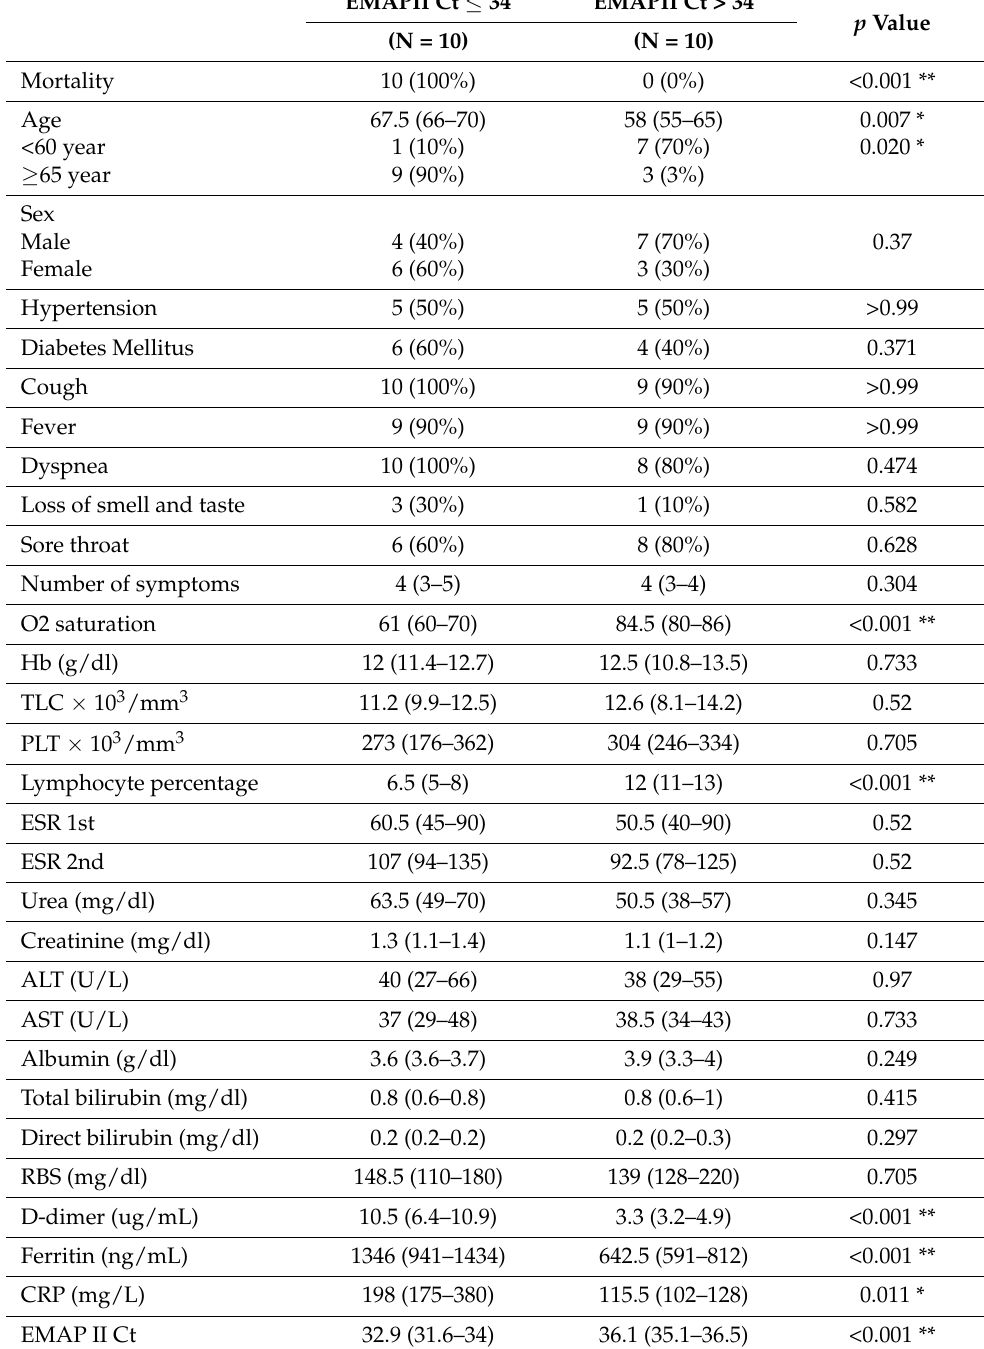
Table 3. Comparison of low and high EMAP II Ct in the severe COVID-19 patient’s